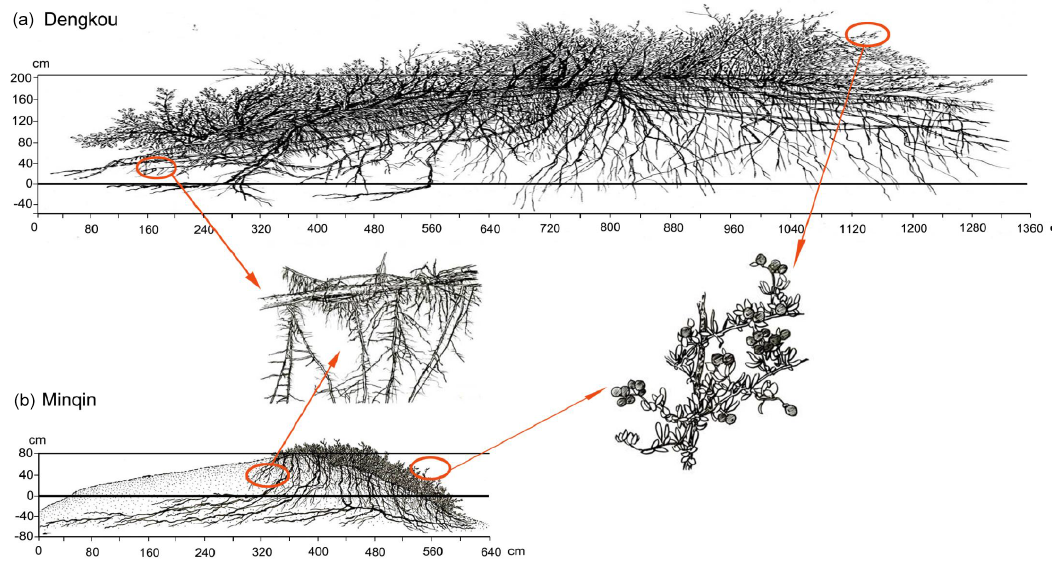
Figure 1. Pen drawings of typical nebkha formed by Nitraria tangutorum Bobrov at the Dengkou (a) and Minqin (b) study sites. The scales shown are for illustrative purposes only and therefore are not very